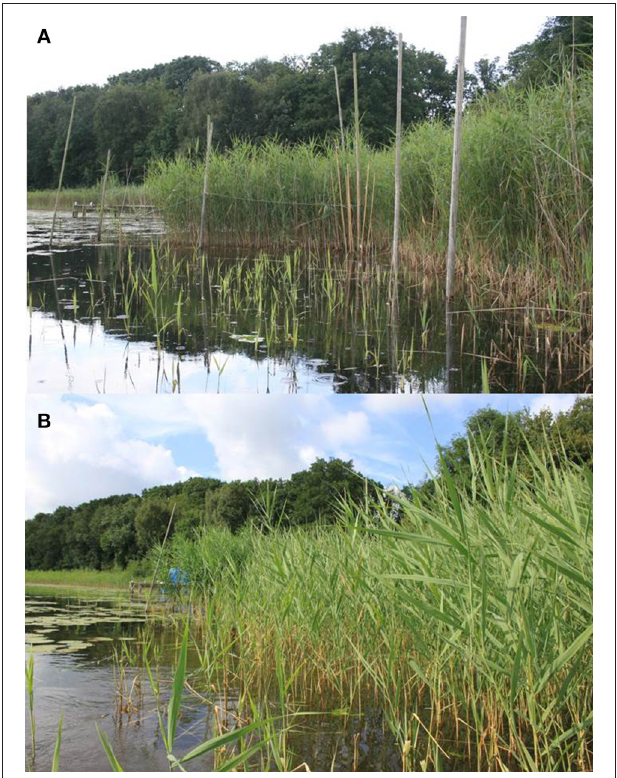
FIGURE 1 | Exclosure design in the study area, Lake Waterleidingplas. (A) An exclosure is visible in the background, marked by 6 poles, with the horizontal upper line of the net just visible across the poles. The exclosure runs from the reed belt on the right into the open water to the left. A tall reed stand is visible inside the exclosure. In front of the exclosure, the adjacent control plot is visible, the two poles on the right mark the shore side of the control plot, from there the plot runs to the left, toward the open water. Sparse and short reed stems are visible in the control plot, which have been grazed in spring and early summer and are now resprouting, 5 August 2008. (B) The same exclosure as in (A) , from the same perspective, but now 5 years later on 31 July 2013, after geese have been actively chased away in spring and early summer by the local water board authority. The exclosure is now hardly visible, as the reed in the control plot and surrounding area has grown tall in the absence of goose grazing.